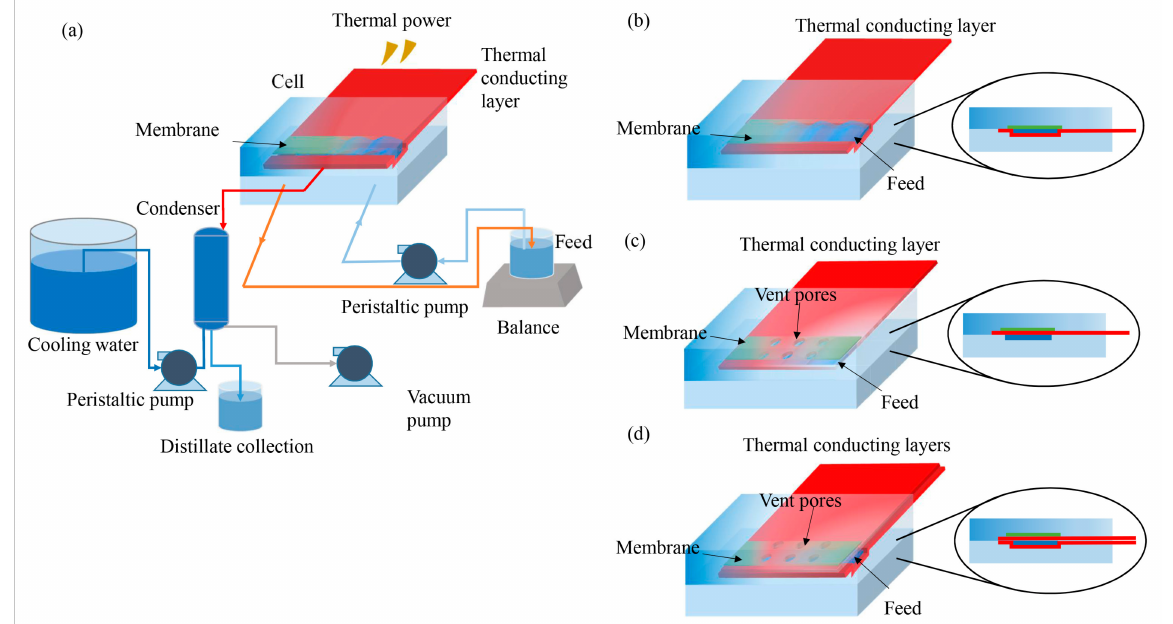
Figure 1. Schematic diagram of the experimental setup for ( a ) schematic of a laboratory-scale surface heating VMD system; ( b ) SHVMD-1 system: the aluminum shim was embedded into the feeding channel; ( c ) SHVMD-2 system: the aluminum shim was placed close to the membrane surface of the feed side; ( d ) SHVMD-3 system: double-layer shims, one of which was embedded into the feeding channel, and the other was placed close to the membrane